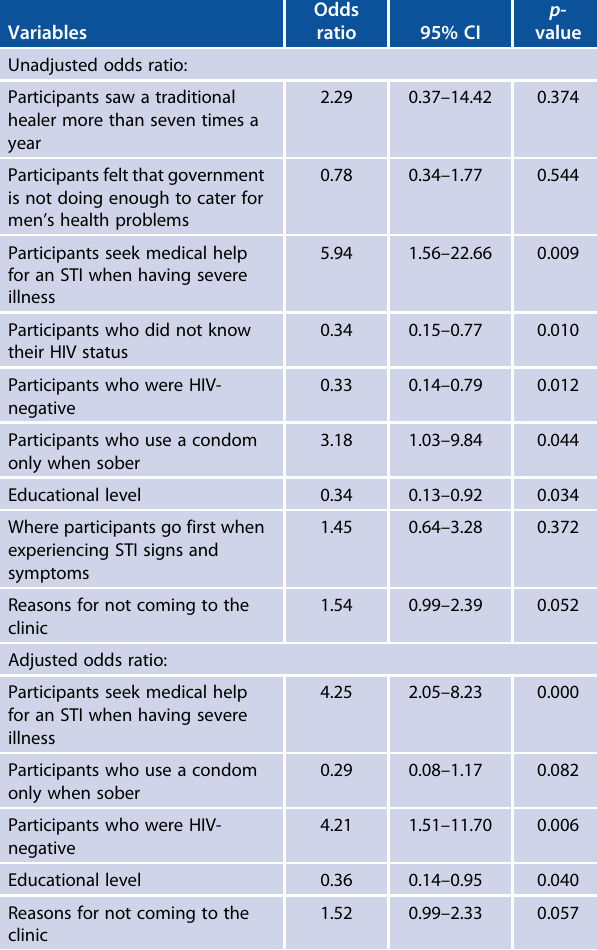
Table 4: Unadjusted and adjusted odds ratio (95% CI) of factors associated with delayed health seeking behaviour ( n = 134) Variables